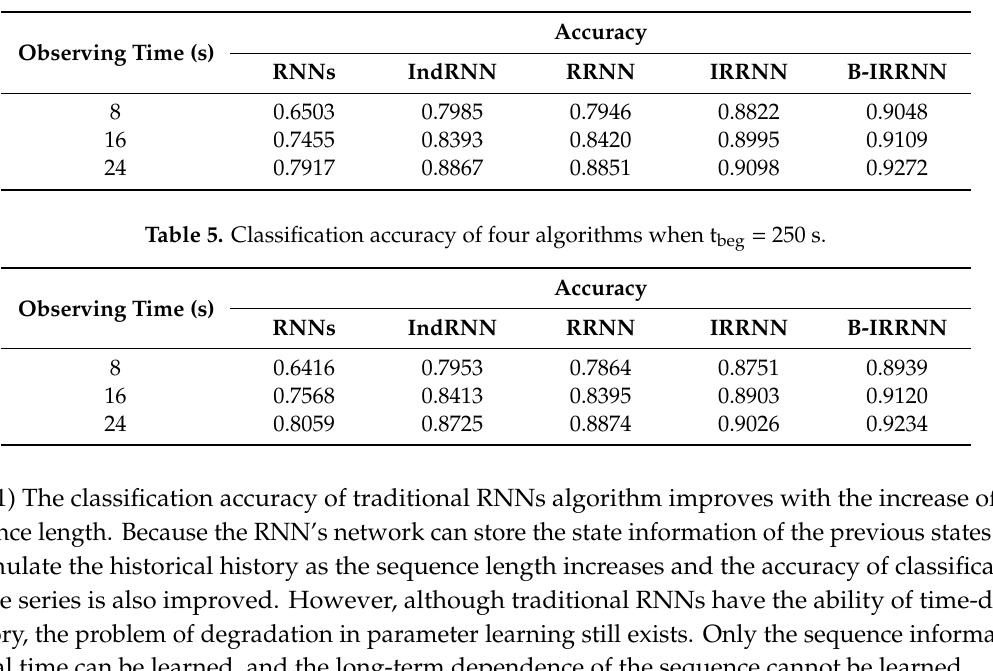
Table 4. Classification accuracy of four algorithms when t beg = 200 s.